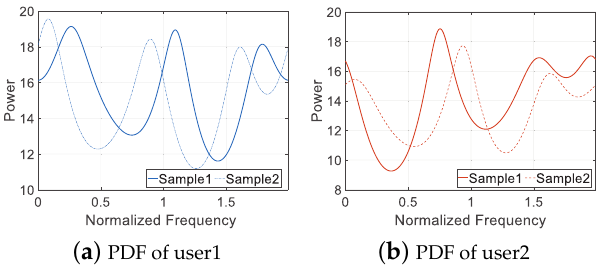
Figure 3. Feasibility analysis by power spectral